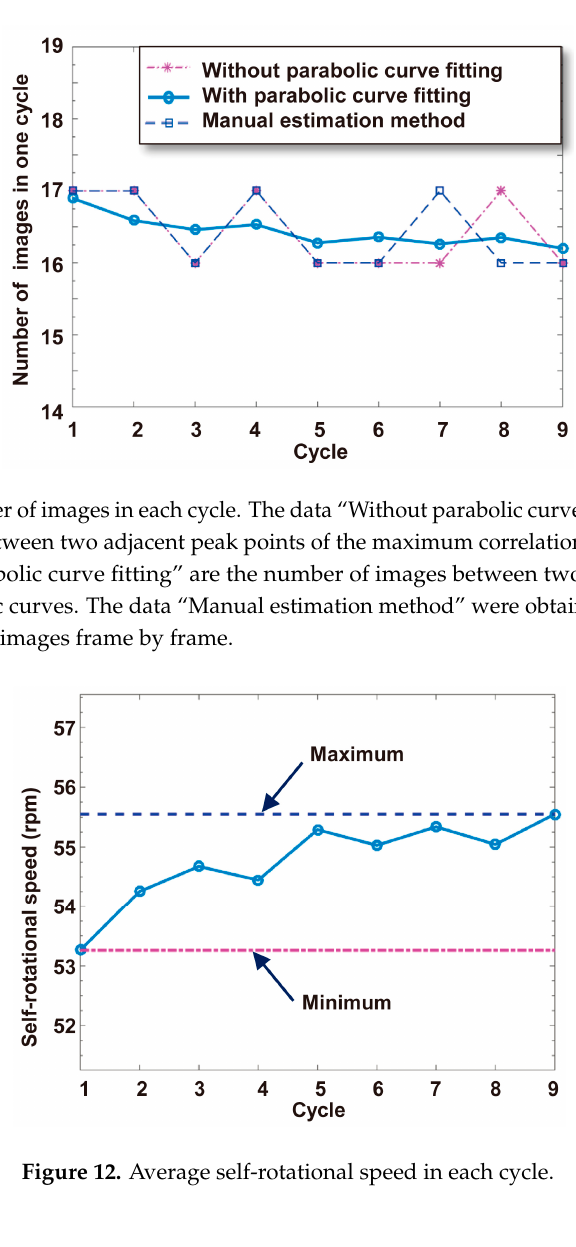
Figure 12. Average self-rotational speed in each cycle.